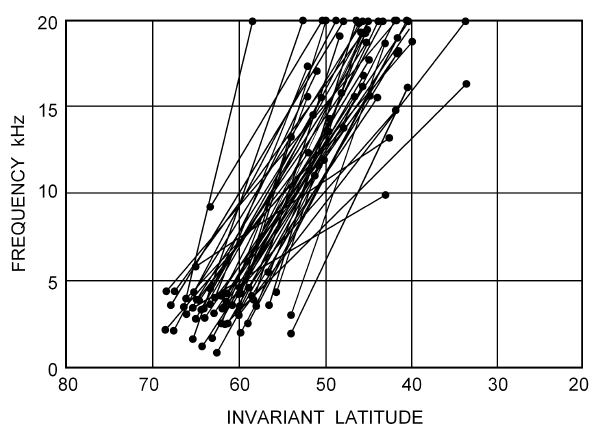
Fig. 6. Frequency band of the LHR band emissions with respect to invariant latitudes. The filled circles show the observed highest and lowest frequencies of the emissions. Note that the line connecting two circles is not the frequency trace of the phenomena.